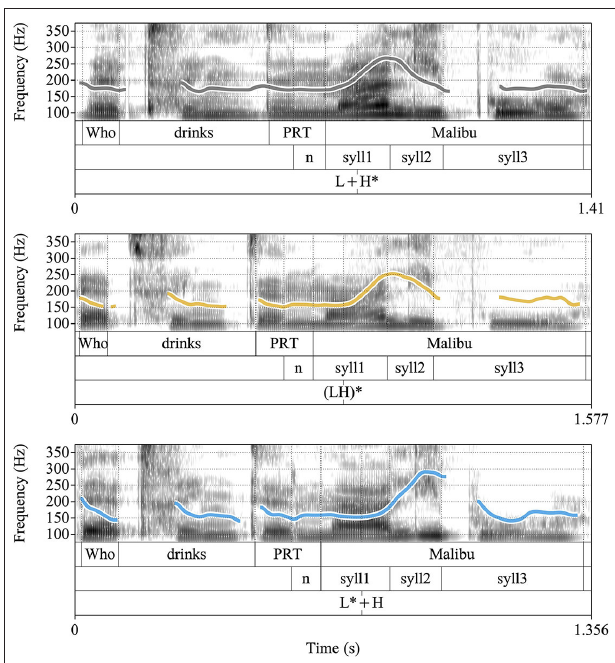
FIGURE 2 | Imitative productions of the German target question Wer trinkt denn Malibu ? ‘Who drinks Malibu?’ in the three intonation conditions (vp19, Northern German group, female, 24 years). Top panel: L + H*, mid panel: (LH)*, bottom panel: L* + H. Tier 2 served as input tier for the extraction of f0 values; all other tiers are for illustration purposes